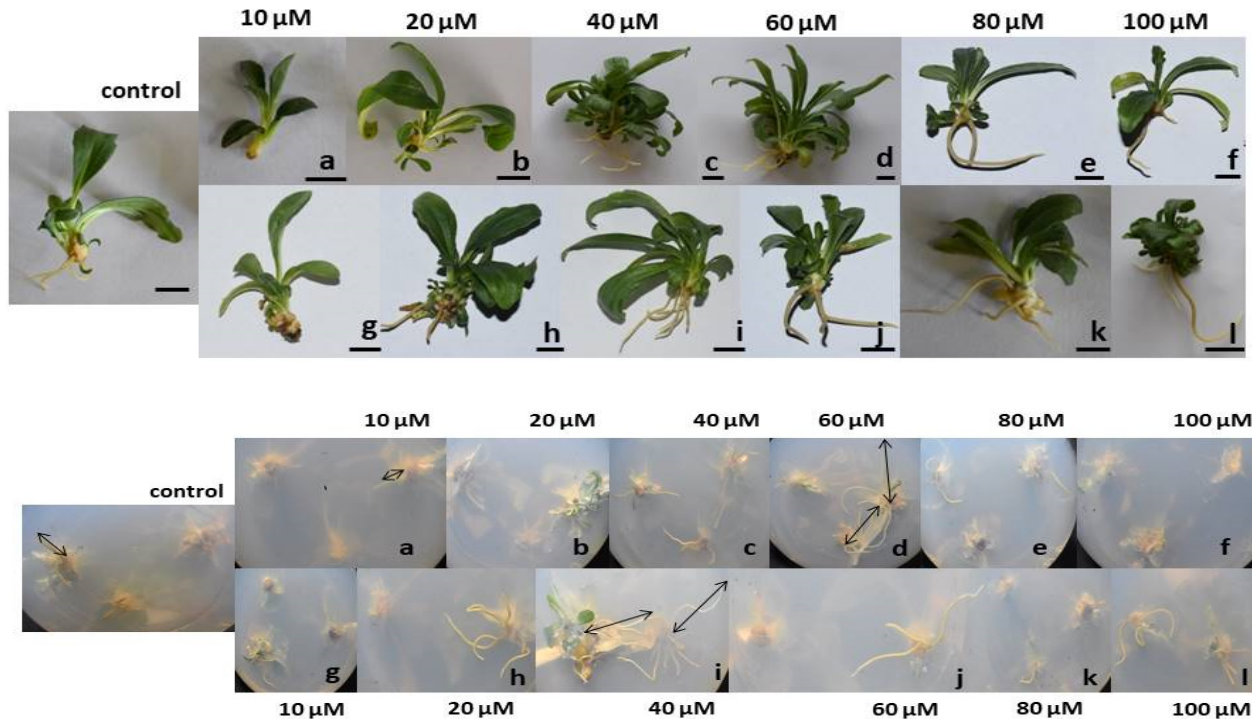
Figure 2. In vitro shoot and root proliferation in the citrate-AuNP and CTAB-AuNP treated N. jatamansi plants. Upper panel: shoot proliferation in the citrate-AuNP treated ( a – f ) and CTAB-AuNP treated ( g – l ) plants. Black lines show the root length. Lower panel: the root length and number of roots in the citrate-AuNP ( a – f ) and CTAB-AuNP treated ( g – l ) N. jatamansi plants. Scale bar = 1 cm.